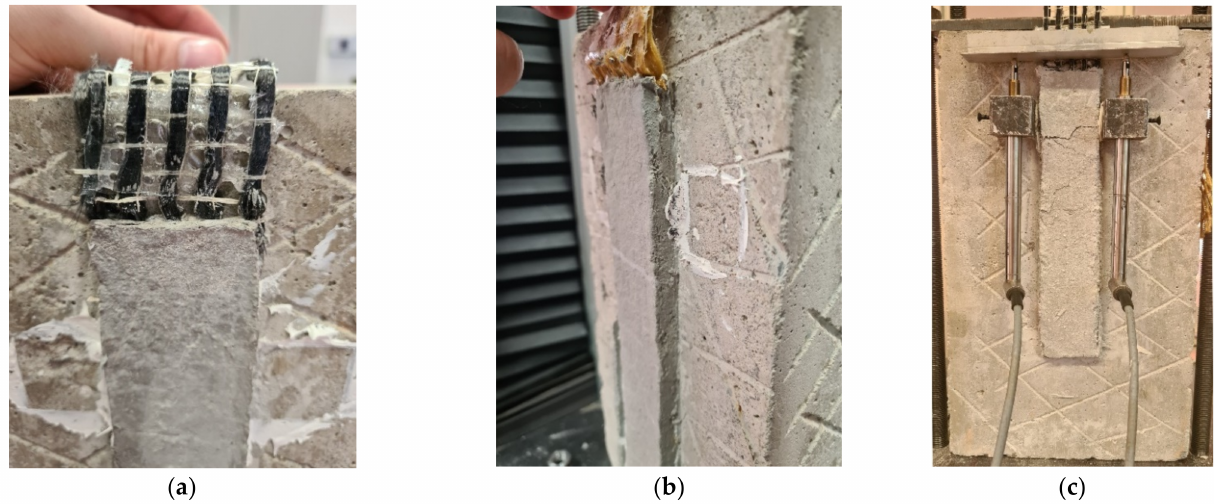
Figure 8. Failure mode observed in: ( a ) DS-C-HW-1L-1000h-2, ( b ) DS-PBO-HW-2L-3000h-3, and ( c )